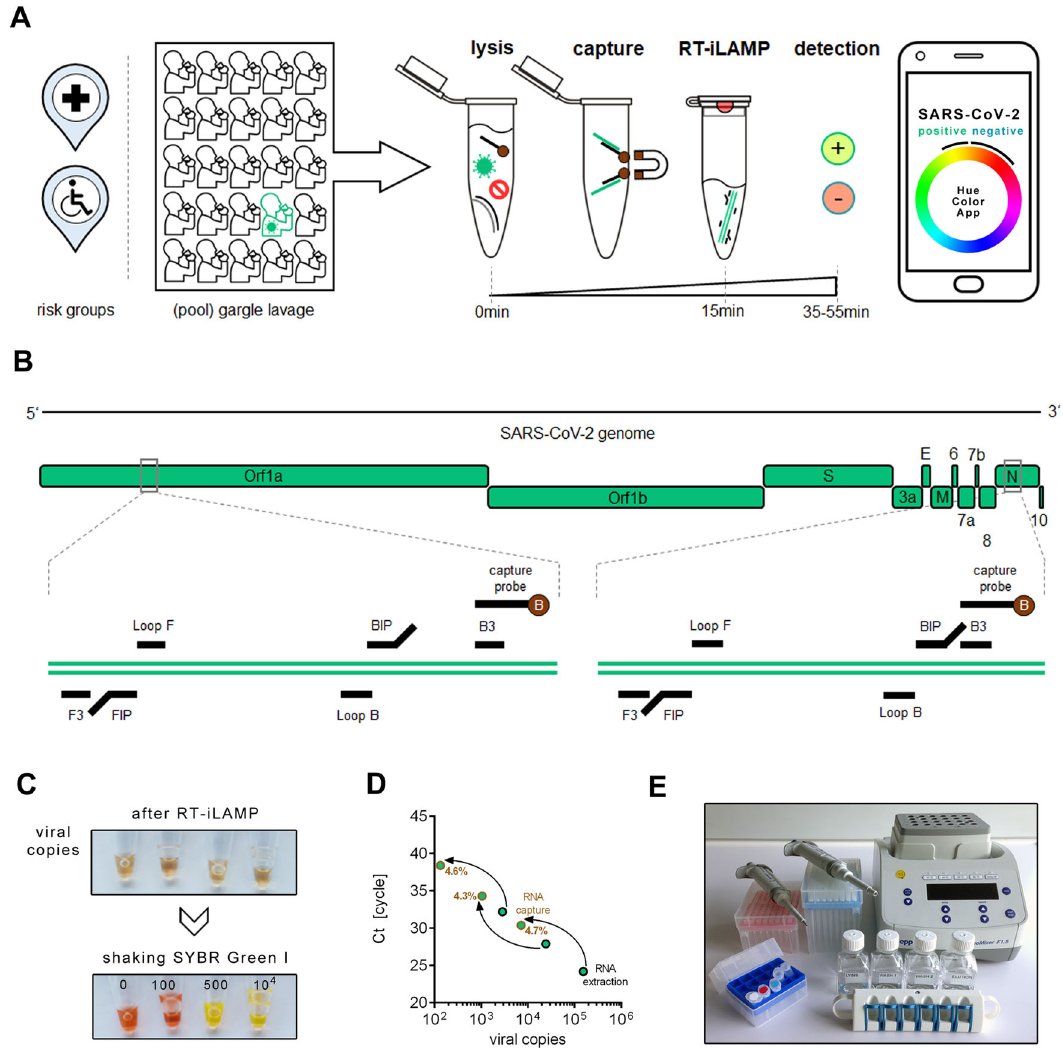
Fig. 1 Cap-iLAMP to detect SARS-CoV-2. A Work fl ow of Cap-iLAMP involves collecting and optionally pooling up to 26 gargle lavage samples, followed by combined lysis, target RNA enrichment, and improved LAMP (iLAMP). Color hue values can be obtained using any freely available “ camera color picker ” application on a smartphone. B Positions of primers and biotinylated capture oligonucleotides targeting the viral Orf1a and N gene on the SARS-CoV-2 genome. C Color change induced by mixing a drop of SYBR green I in the lid of the tube after iLAMP reaction with different input copy numbers of synthetic viral RNA. D Capture ef fi ciency of three samples with different viral loads was estimated relative to automated silica-based RNA extraction based on copy number estimates for RT-qPCR assay targeting the SARS-CoV-2 E gene. Source data are provided as a Source Data fi le. E Equipment necessary for Cap- iLAMP: Pipettes and pipette tips, pre-mixed reagents (including iLAMP master mix and capture bead suspension), stable buffers (lysis/binding buffer, wash buffer, low salt buffer, elution buffer), a magnetic rack, and a thermoblock. A smartphone (not depicted) is recommended for hue color